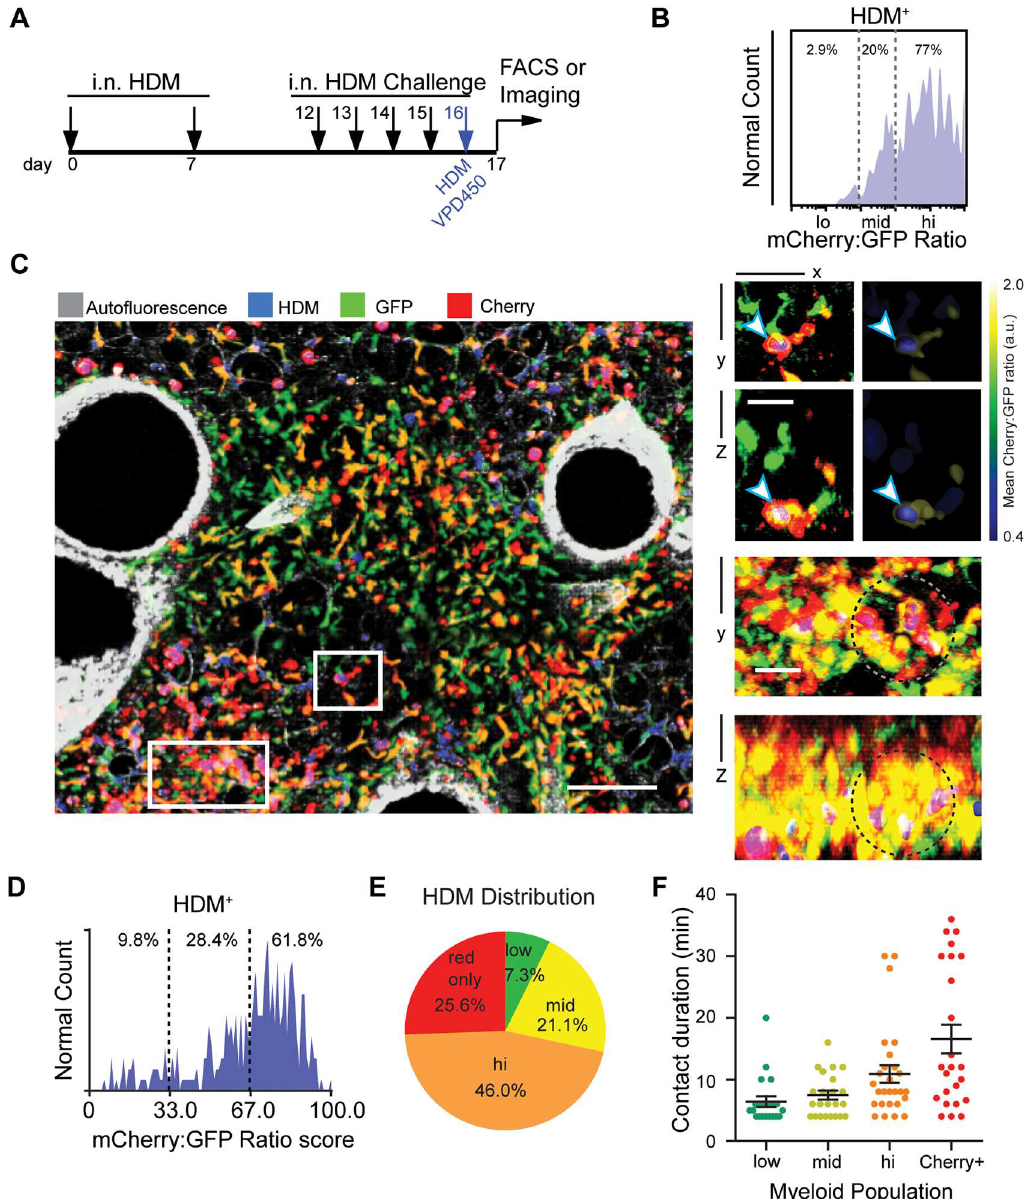
Fig 5. Antigen uptake and T cell engagement increasefor differentiated monocytes. ( A ) Protocol for inhalation of fluorescent VPD450 + HDM to score for efficiency of antigen capture in myeloid cells in situ . LabeledHDM was administered i.n. on day 16 in a protocol which otherwiseclosely resembledthat outlined in S1 Fig. ( B ) Flow histogram showingdistributionof HDM taken up by CD45 + CD11b + Siglec-F - Ly6G - lung leukocytes on the Cherry:GFP color scale, with percentages of VPD450+ cells shown above and demonstrating dominanceof uptake by the most differentiated cells. ( C ) Two photon micrographof HDM-treated lungs showingGFP + and/or Cherry + cells. Note blue positivity for multiple populationsand across the lung. Scale bar = 100 μ m. Right: XY and XZ sectional views of the regions marked in C showingHDM particles within moDCs (white arrow, bound by blue) and accumulation of ratio-mid and ratio-hi cells around HDM particles (beads appear purple, region of interest indicatedby dotted circles). Scale bars = 20 μ m. ( D, E ) Quantification of endocytosed HDM observed by two-photonmicroscopy, shown as (D, histogram; excludingCherry + only cells) or including( E , pie chart; includingCherry+only cells). ( F) Contact duration between adoptivelytransferred and labeledOTII T cells and the indicatedmyeloid population at 16 hour post T cell transfer in a similar OVA-model for antigenuptake (see S4 Fig), derived from timelapse imagingof lungs as previously described[11]. Dwell times > 4 min are considered. All data taken from at least 3